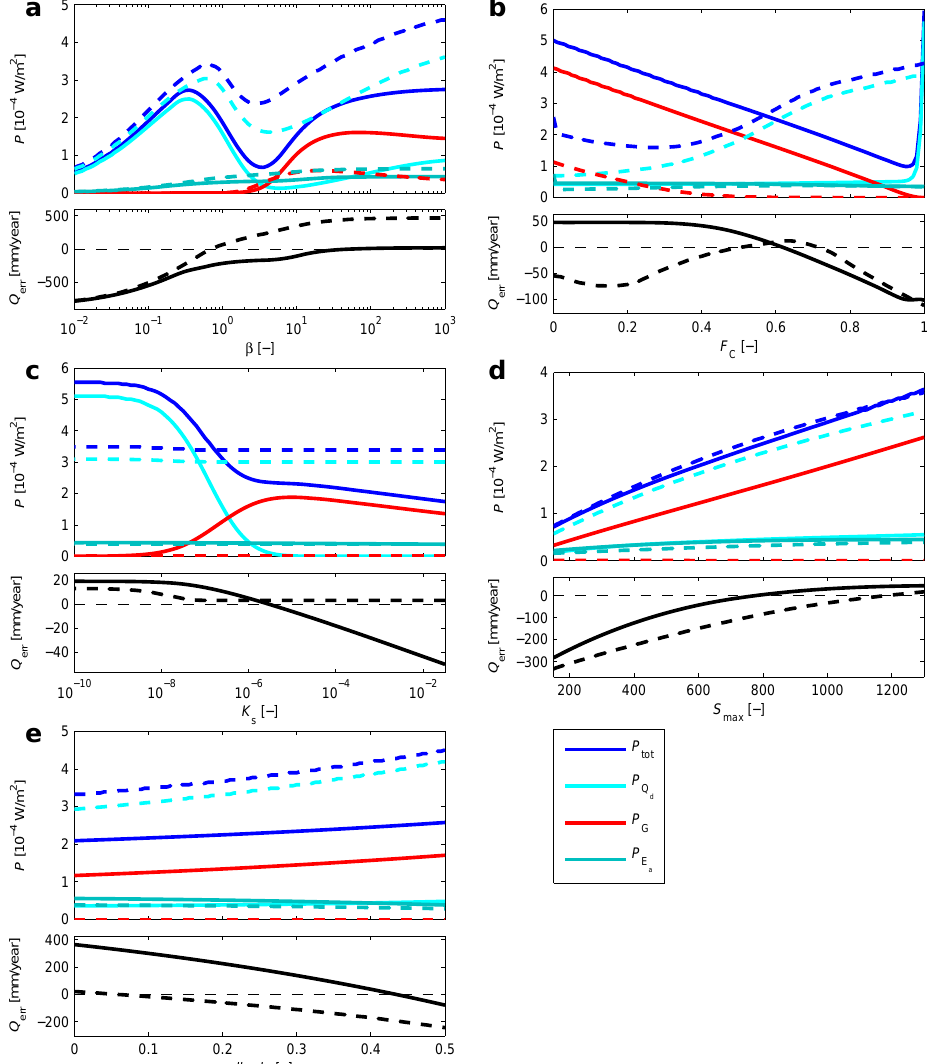
Fig. 2. Sensitivity of (a) β , (b) F C , (c) K s , (d) S max and (e) albedo to power of the different fluxes leaving the unsaturated zone and associated mass balance error for the HJ Andrews watershed 2. Total power is plotted in blue, power by Q d in light cyan, power by G in red and power by E a in dark cyan. The dotted and dashed lines represent two different parameter sets (see Table